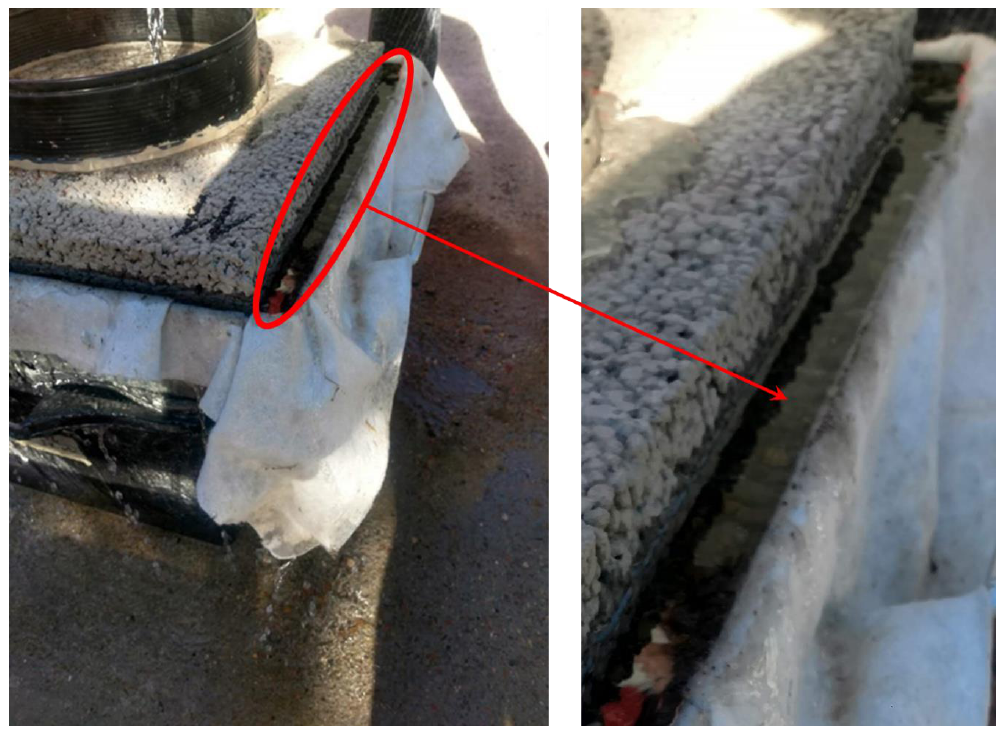
Figure 9. Water film as a result of a discrepancy in pervious concrete infiltration and unbound base course (UBC)